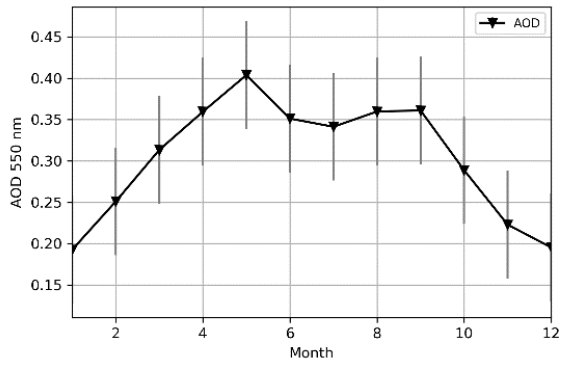
Figure 6. AOD climatology from MODIS Terra over Egypt for the period 2012–2018; the vertical line represents standard deviation.